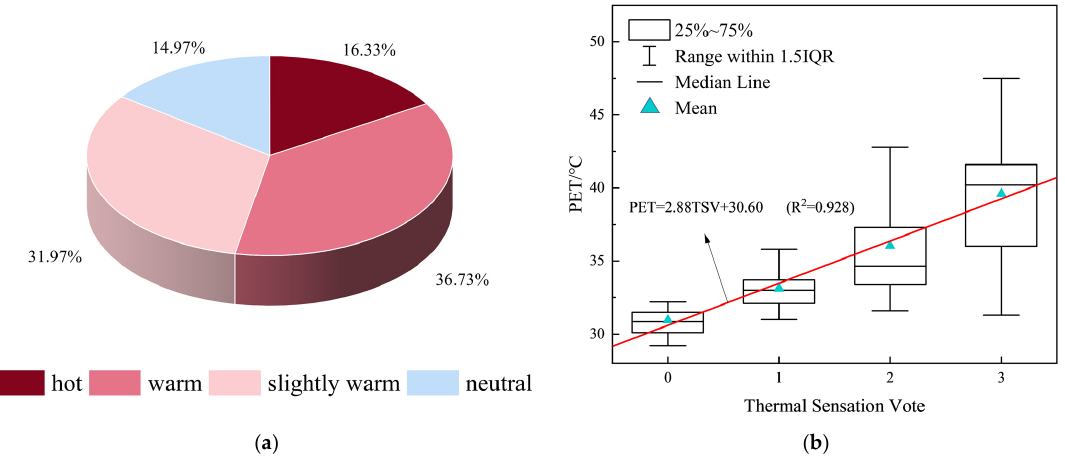
Figure 5. ( a ) Proportion distribution of TSV. ( b ) Statistical results of PET under different TSV scales.